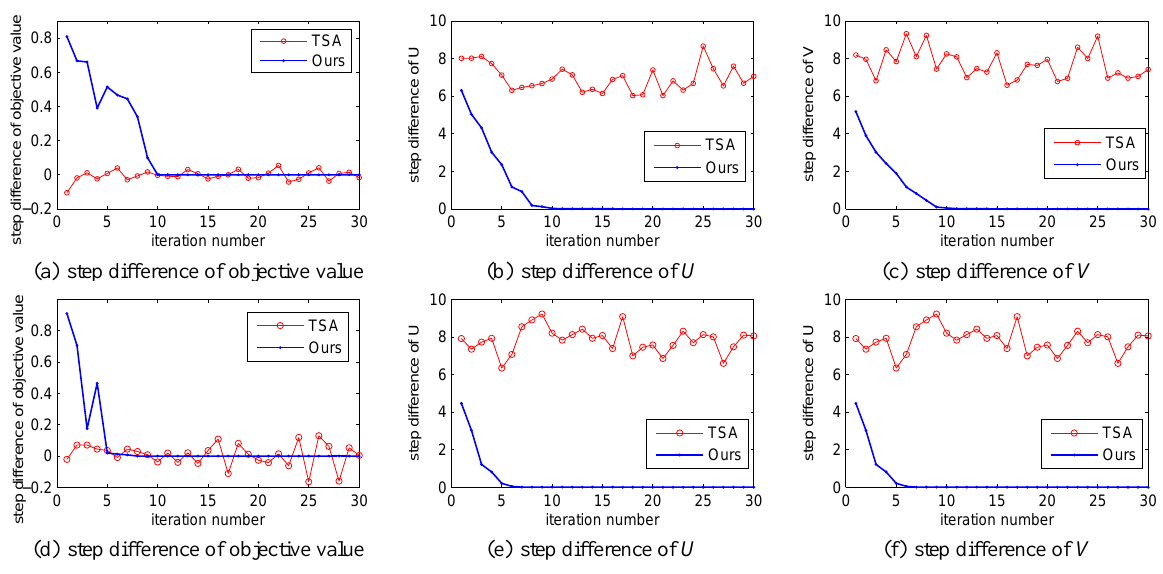
Figure 4: Convergency of the iterative procedure on the two face databases. (a,b,c) results on PIE database; (d,e,f) results on Yale database by considering all possible feature